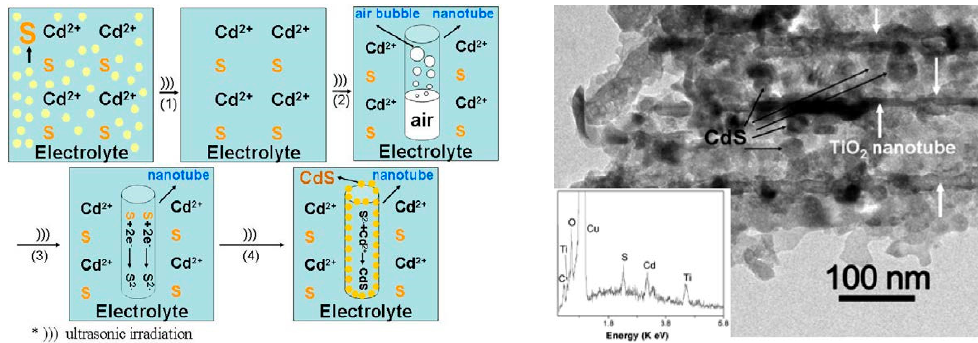
Figure 7. On the left: a schematic diagram of the possible sonoelectrochemical deposition interaction. On the right: a transmission electron microscopy (TEM) image of CdS-TiO 2 NTs after CdS sonoelectrochemical deposition with the inset energy dispersive X-ray (EDX) spectrum. Reprinted from [34]. © IOP Publishing. Reproduced with permission. All rights reserved.